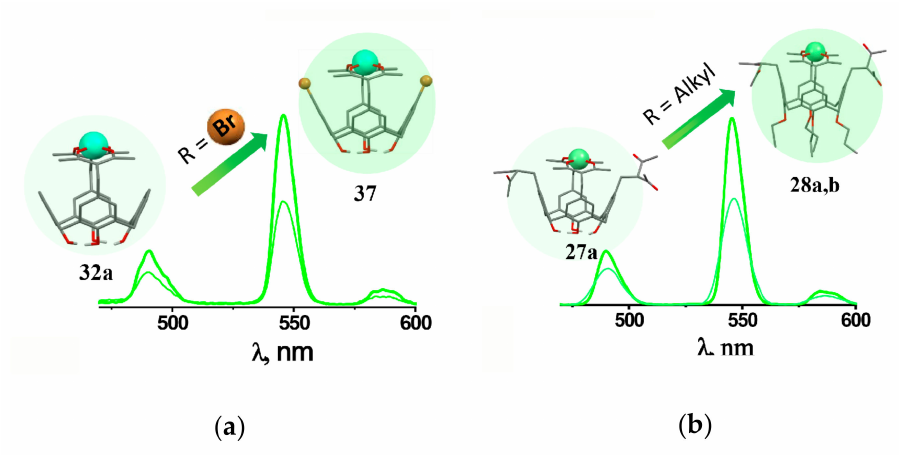
Figure 7. Cartoon illustration of the effect of lower rim ( a )and upper rim ( b ) substituents on the Tb 3+ - centered luminescence of [Tb 3+ L] complexes with differently substituted 1,3-diketone calix[4]arenes. Reproduced from Ref. [59] ( a ) with permission from the